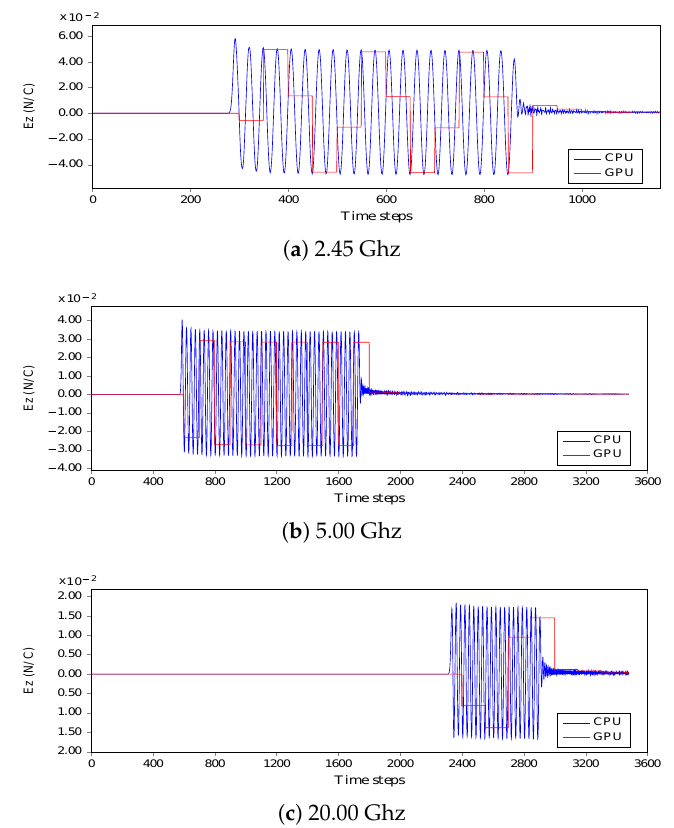
Figure 11. Comparison of the solution along the time obtained in the GPU vs. CPU in viewer 3. Very similar solutions were obtained for viewers 1 and 2. The solution can only be compared when the information is transferred to the